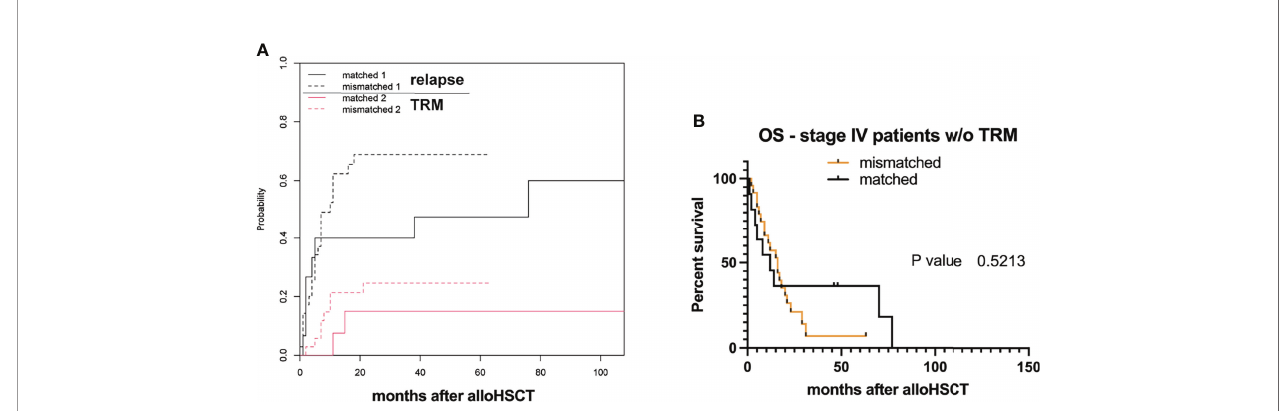
FIGURE 2 | Transplant-related mortality (TRM) and survival. (A) Estimated cumulative incidence curves with relapse and transplant-related mortality (TRM) as competing events after allo-HSCT for HLA-mismatched versus -matched grafts. (B) Overall survival (OS) probabilities after allogeneic hematopoietic stem cell transplantation (allo-HSCT) within study group populations neglecting TRM ( w/o without).